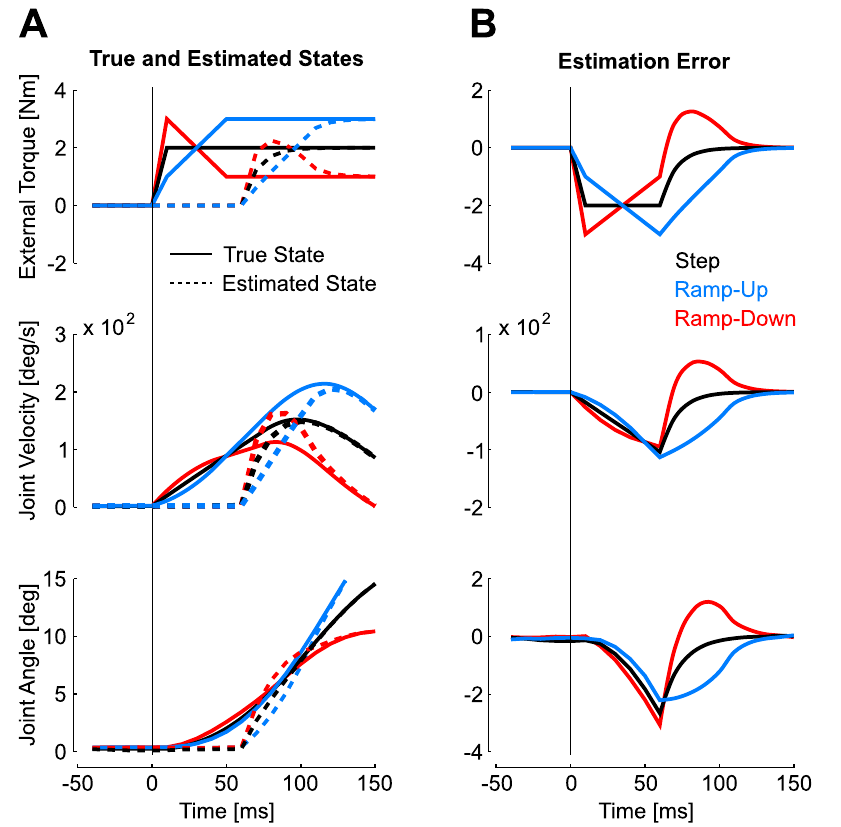
Figure 5. State estimation following unexpected perturbations. A: Illustration of the actual (solid) and estimated (dashed) state variables. From top to bottom, displays are the external torque (T E ), the joint velocity and the joint displacement. 2 Nm step perturbation is represented in black, ramp-down in red and ramp-up in blue. B: Estimation error for each perturbation profile, defined as the difference between the estimated state and the true